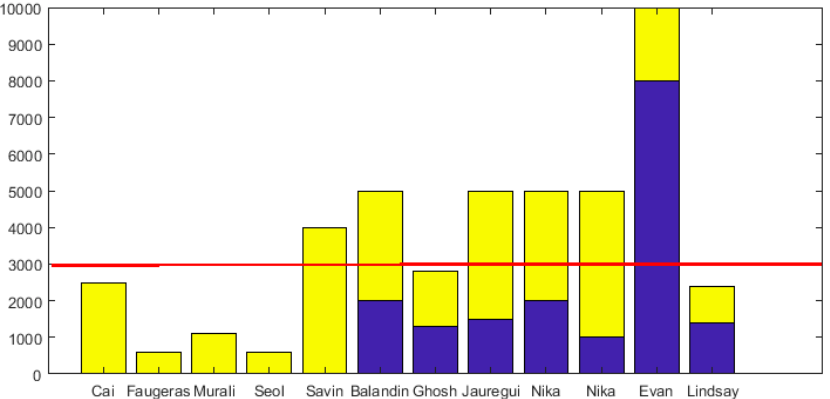
Figure 1. Thermal conductivity of graphene (unit: W/mK).